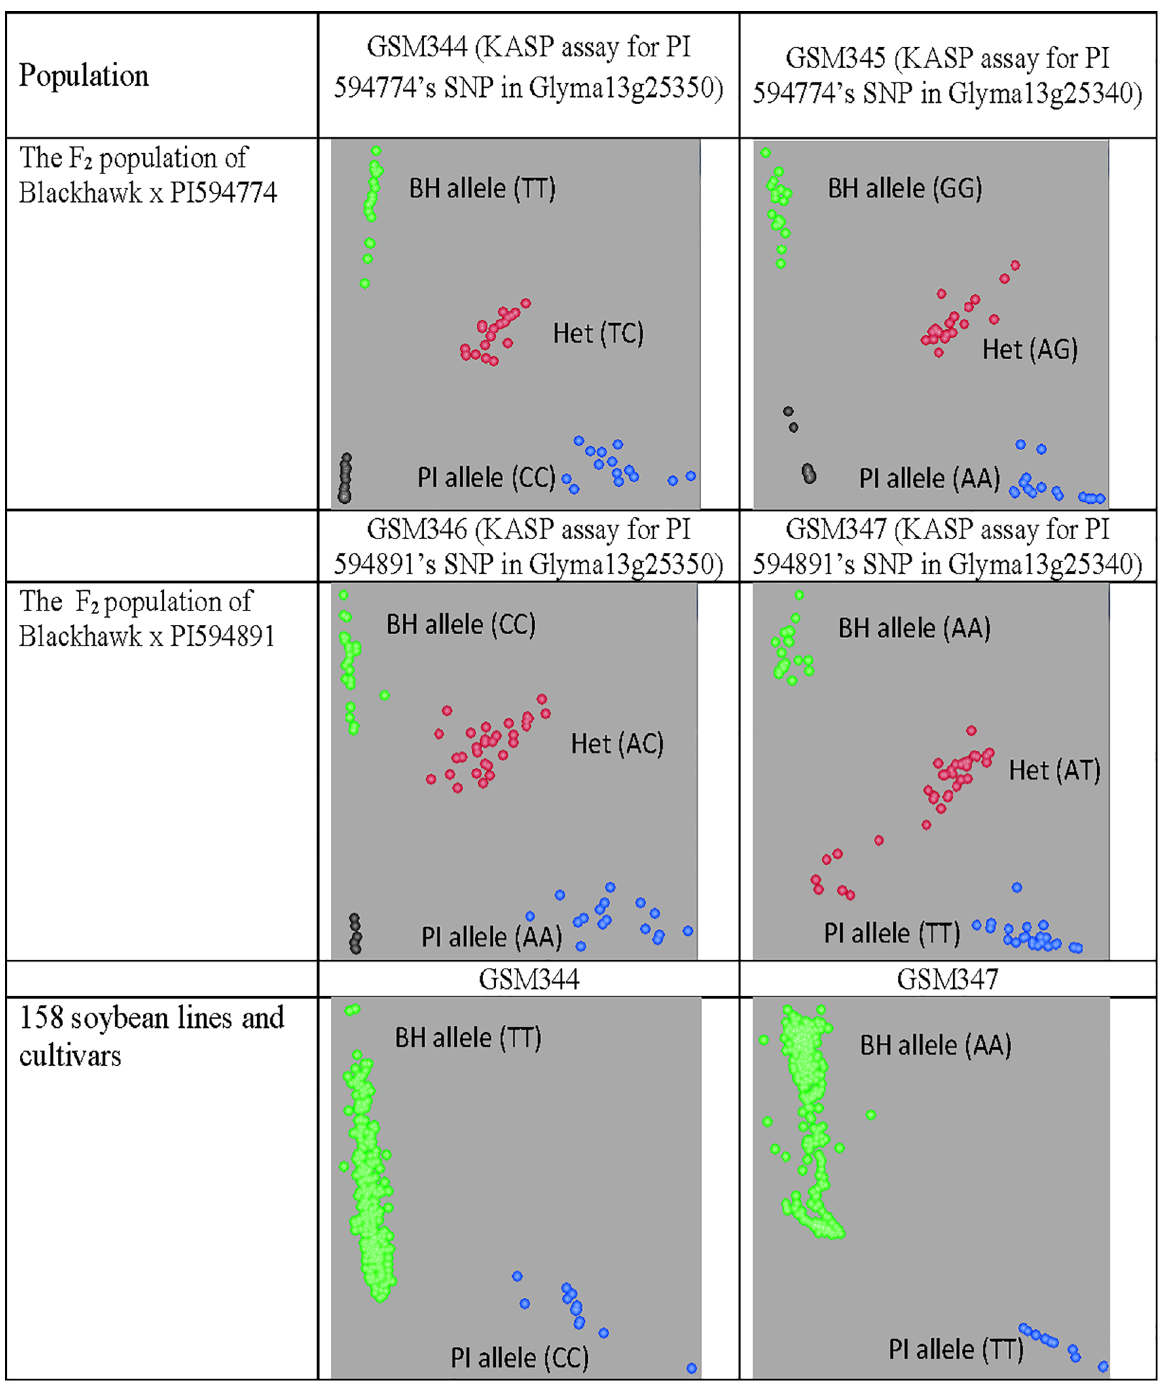
Fig 4. SNP graphs of KASP assays for the F 2 populations of Blackhawk x PI 594891/PI 594774 and 158 soybean lines and cultivars. (BH = Blackhawk allele; PI = PI 594774 allele; Het = heterozygous alleles).